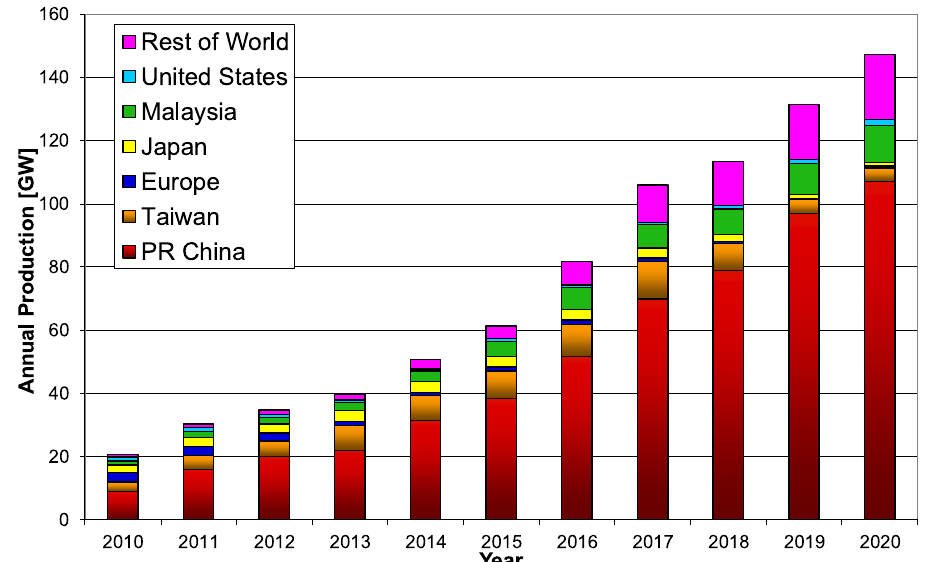
Fig. 1. World PV cell/thin fi lm module production from 2010 to